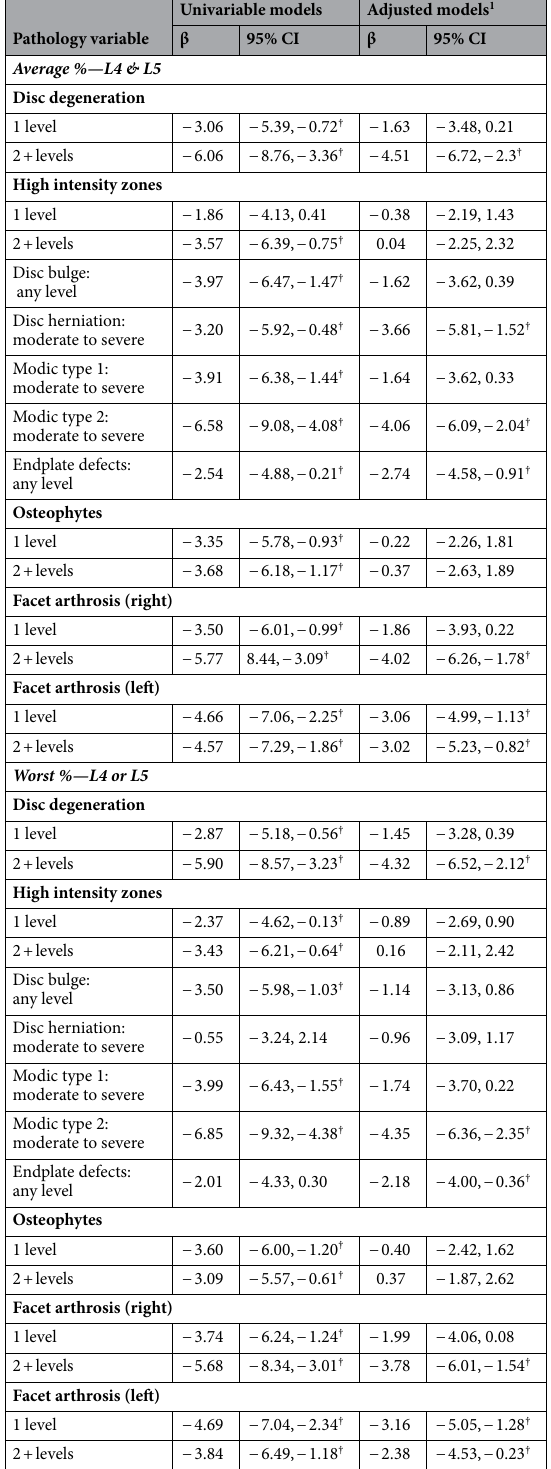
Table 4. Linear regression [individual pathologies]: average and worst % MCSA. 1 Adjusted for age, sex, and BMI. † Significant difference from reference (for each pathology variable, the reference category is either the absence of the condition, or the absence of moderate to severe findings for that condition). β, unstandardized beta coefficient; CI, confidence interval; % MCSA, proportion of peak muscle cross-sectional